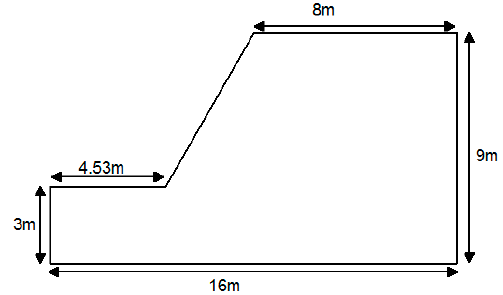
Figure 8. The geometry profile of the slope example. Materials 2017 , 10 , 240